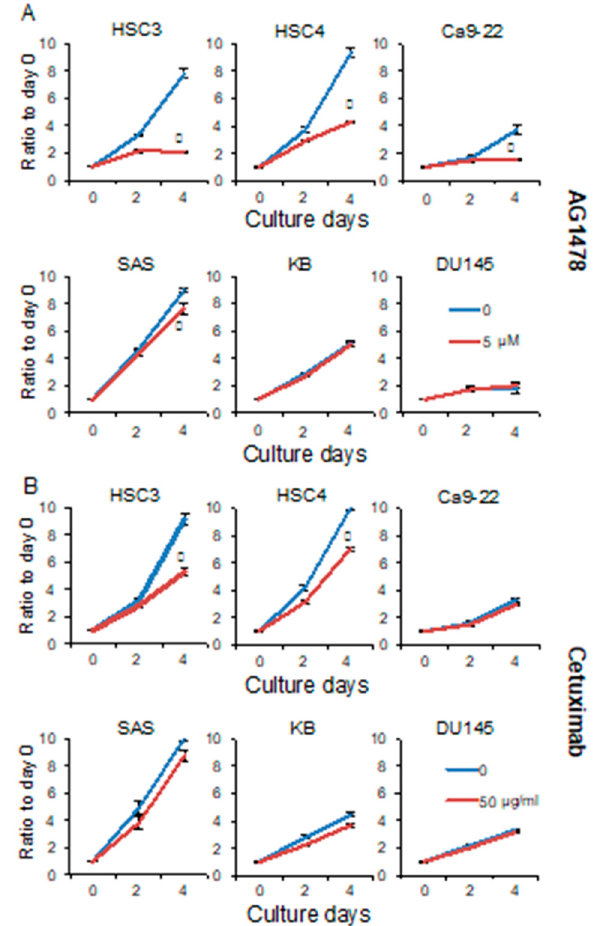
Figure 1. AG1478 and cetuximab have different inhibitory effects on growth of epidermal growth factor receptor (EGFR) inhibitor sensitive (EIS) cancer cells. The HSC3, HSC4, Ca9-22, SAS, KB, and DU145 cells were treated with ( A ) 5 μ M of AG1478 or ( B ) 50 μ g/mL of cetuximab, and MTS assays were performed on days 0, 2, and 4 to assess cell proliferation. A cetuximab of 10 μ g/mL is sufficient to suppress cell growth. In this experiment, 50 μ g/mL was used to reliability determine cetuximab resistance. Blue lines represent untreated control. Red lines represent AG1478 treatment on panel A and cetuximab treatment on panel B. * Significantly different from control, p < 0.05. Experiments were performed three times independently.